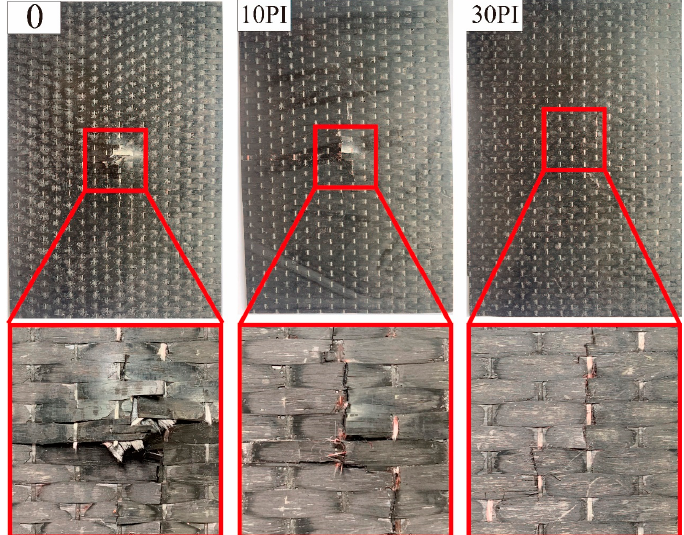
Figure 8. Damage morphologies of non-toughened, 10 PI-toughened, and 30 PI-toughened composites from back view.